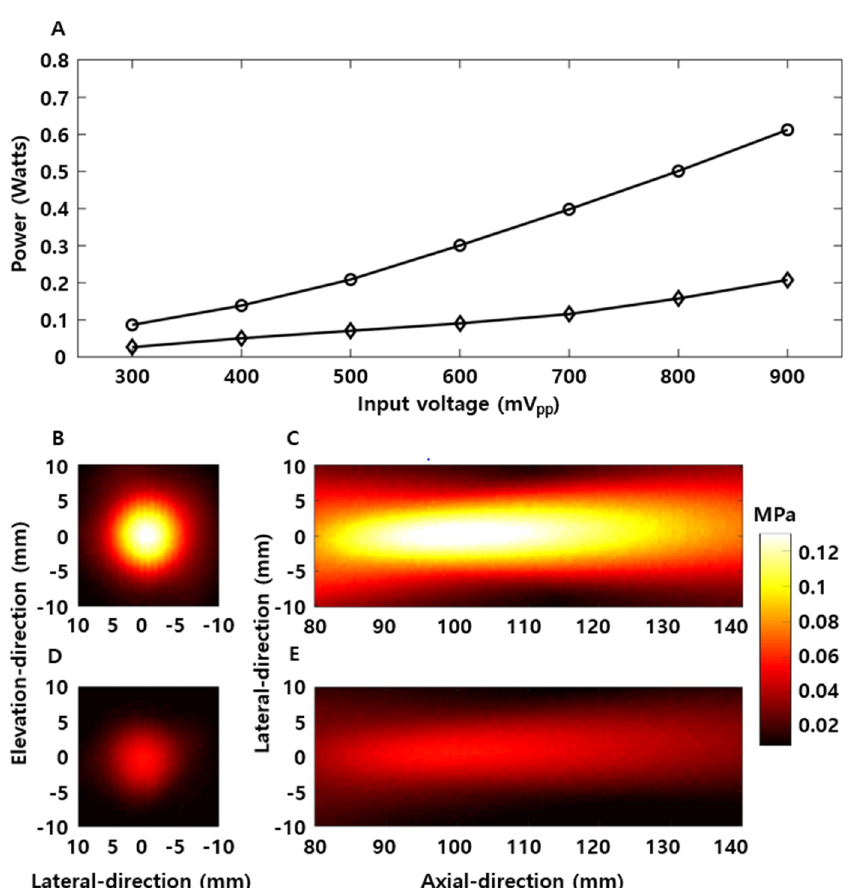
Figure 5. Measurement results of the FUS transducer for deduction of optimal input voltage. ( A ) Relationship between voltage and power of the 250 kHz FUS transducer (circle: free field, diamond: human skull). ( B , C ) Acoustic beam profile in the free field. ( D , E ) Acoustic beam profile in the human skull.